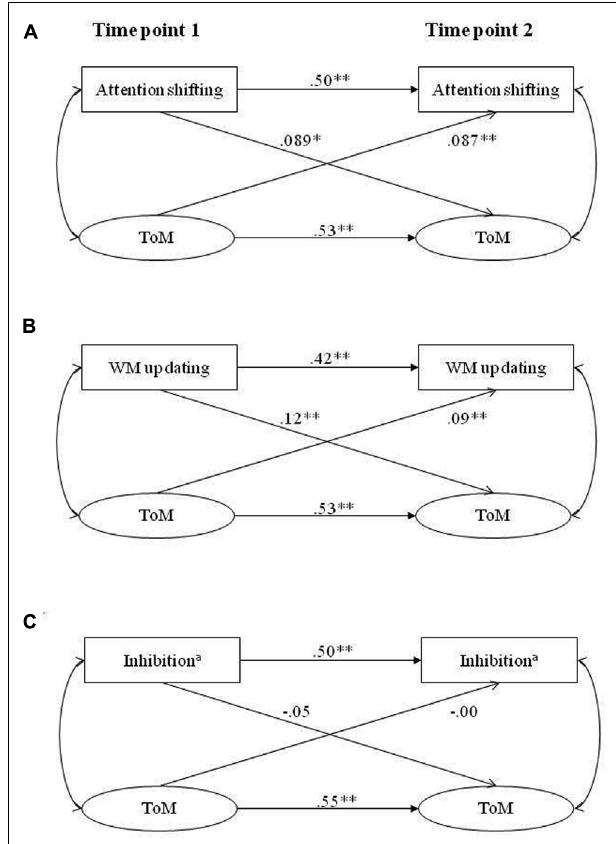
FIGURE 2 | Cross-lagged models for the relations betweenToM and the EF subcomponents attention shifting (A),WM updating (B), and inhibition (C), at the two measurement points, controlling for age, gender, fluid intelligence, as well as for the earlier levels of the target variables. a Interference measure (negatively polarized); ** p ≤ 0.01, * p ≤ 0.05,